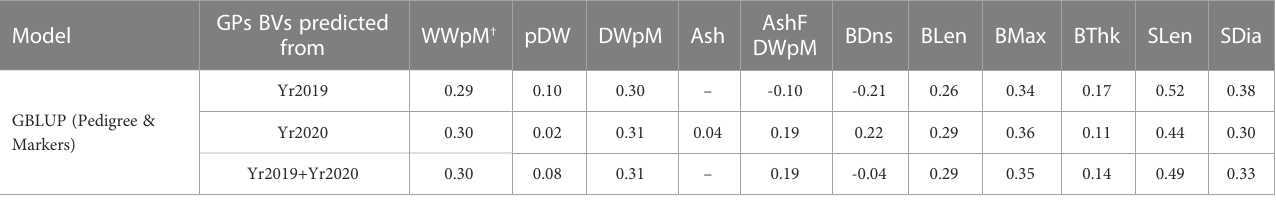
TABLE 5 Genomic prediction accuracy using heterogeneous error variance model, the same model as used in Table 1 . GPs BVs predicted Model from